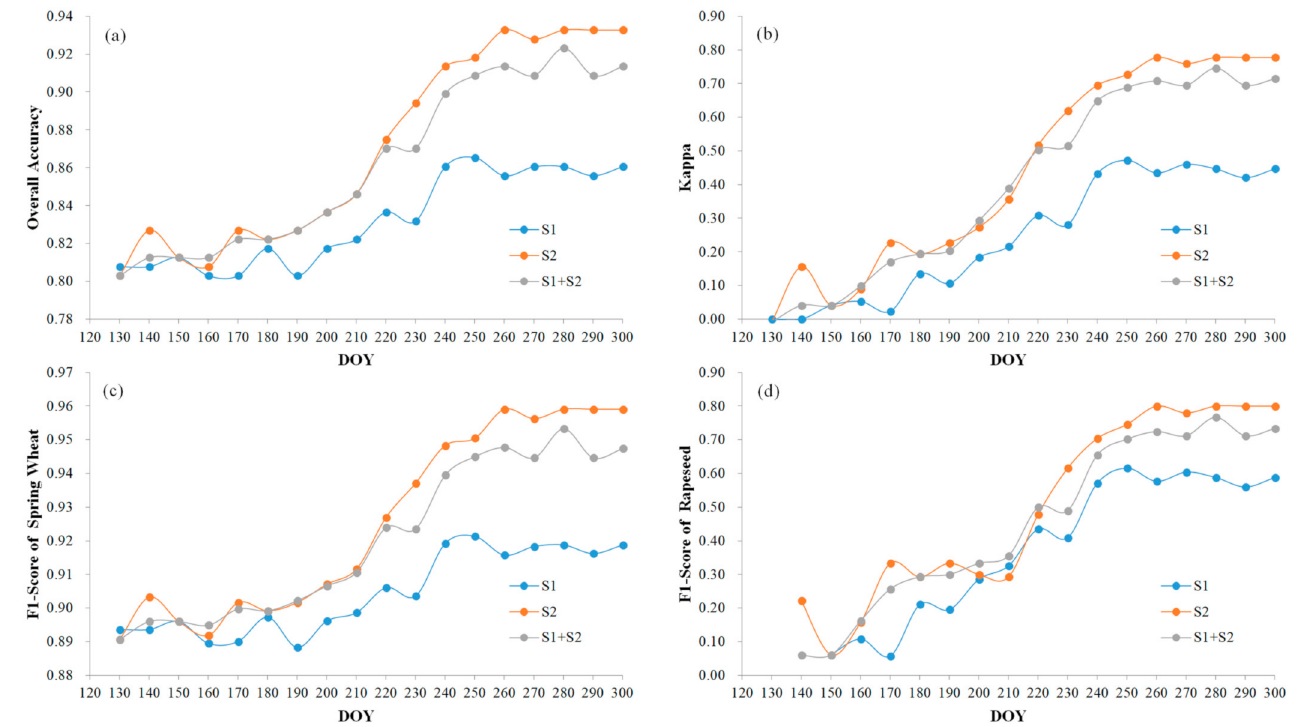
Figure 8. The OA, Kappa, and F1-Score variation under three scenarios. ( a ) OA change; ( b ) kappa coefficient change; ( c ) F1-score of spring wheat; ( d ) F1-score of rapeseed.